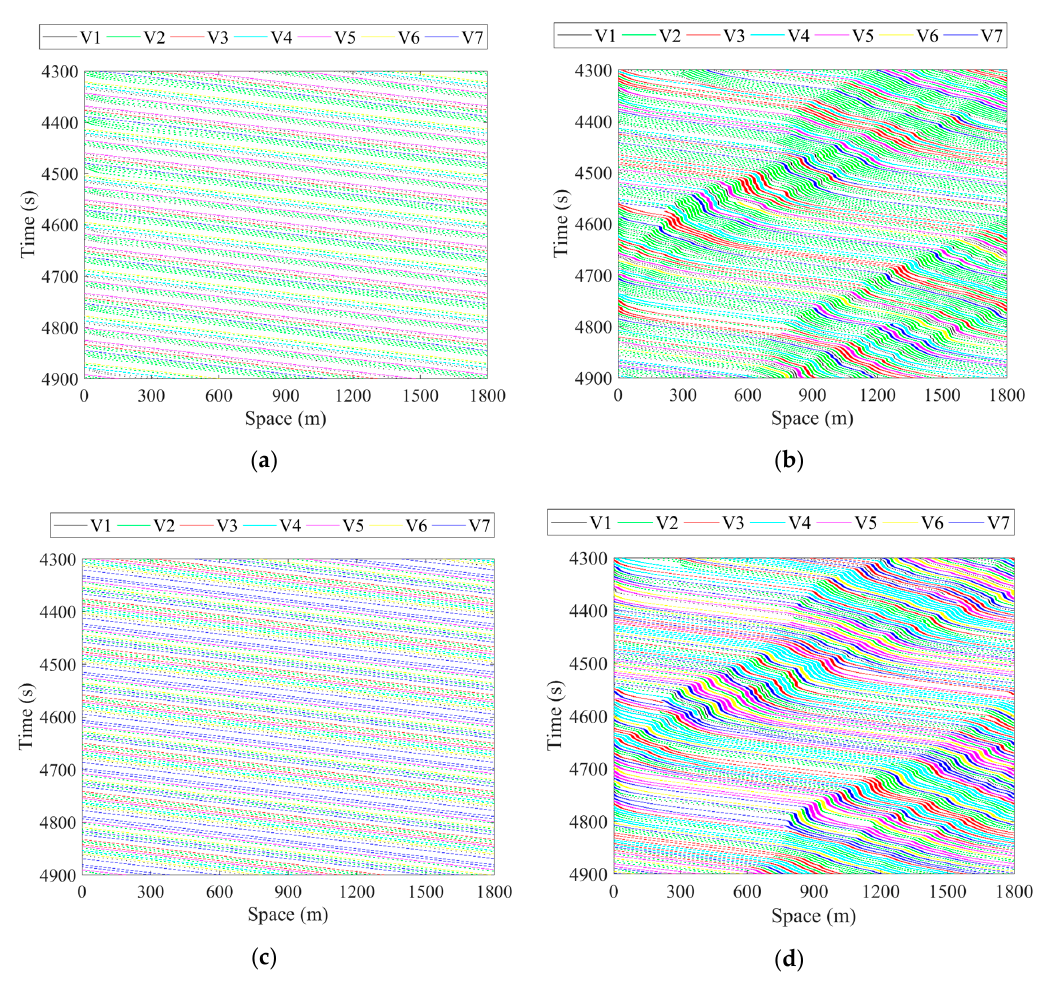
Figure 4. Simulated stochastic traffic flow. ( a ) Fast-lane: Free-flow; ( b ) fast-lane: Busy-flow; ( c ) slow-lane: Free-flow; and ( d ) slow-lane: Busy-flow.